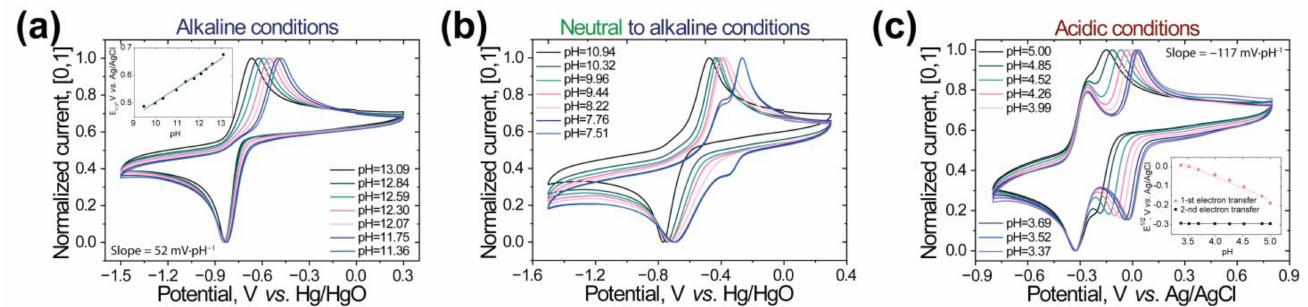
Figure 3. CV curves of M1 solution at different pH values with a scan rate of 100 mV s − 1 at alkaline ( a ), neutral to alkaline ( b ), and acidic ( c )